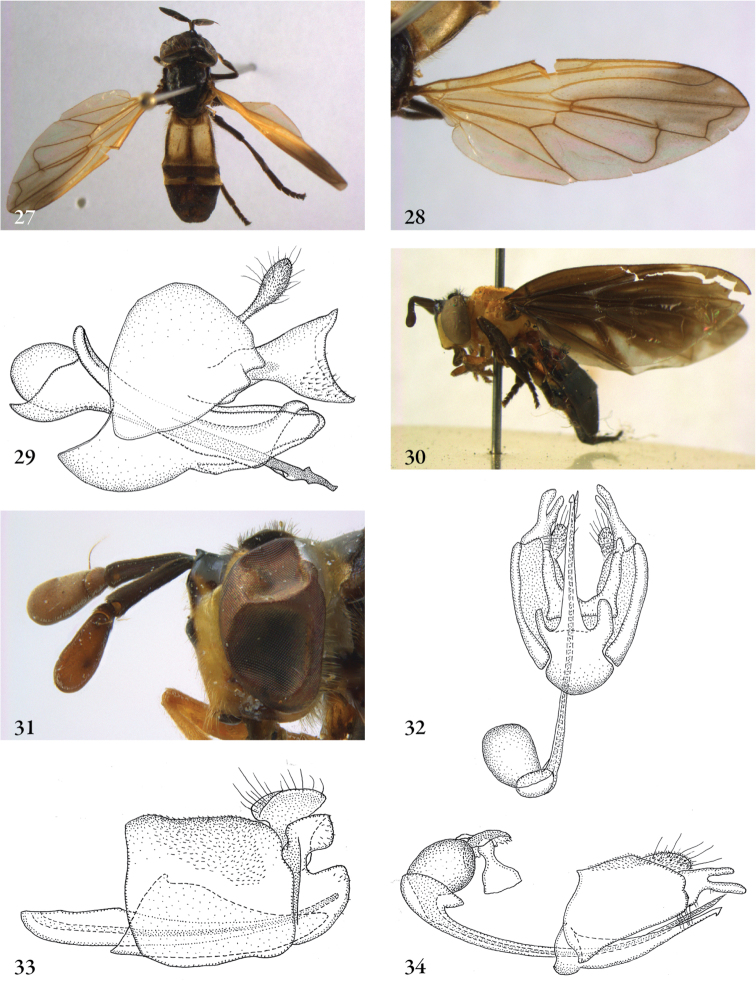
27–29
Aristosyrphus primus male: 27 habitus dorsal (Brazil, coll. J.T. Smit) 28 wing (Brazil, coll. J.T. Smit) 29 genitalia lateral (Brazil, coll. SEMC) 30–34
Aristosyrphus (Eurypterosyrphus) males: 30
Aristosyrphus currani male (holotype), habitus lateral 31
Aristosyrphus. spec. (Brazil, coll. ZMAN), head lateral 32
Aristosyrphus spec. #1 (Costa Rica, coll. ZMAN), genitalia ventral 33
Aristosyrphus spec. #2 (Brazil, coll. ZMAN), genitalia lateral 34
Aristosyrphus spec. #1 (Costa Rica, coll. ZMAN), genitalia lateral.